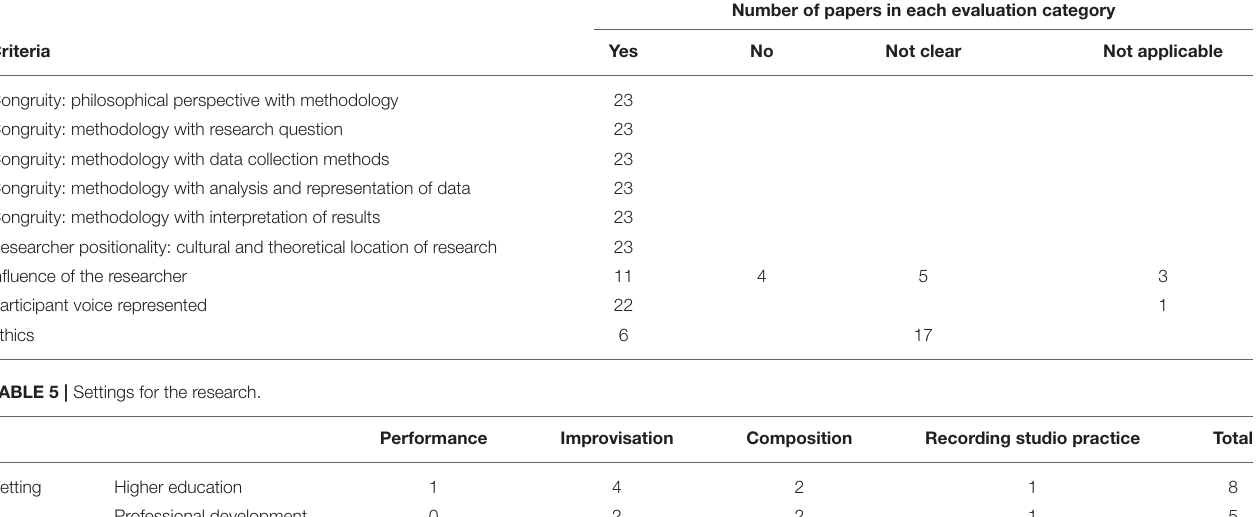
TABLE 4 | Criteria for assessment of methodological rigor.